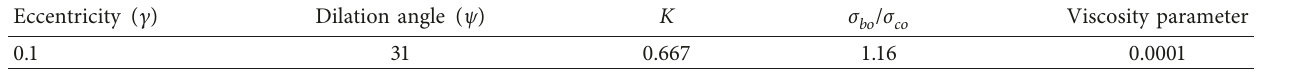
Table 1: Concrete damage